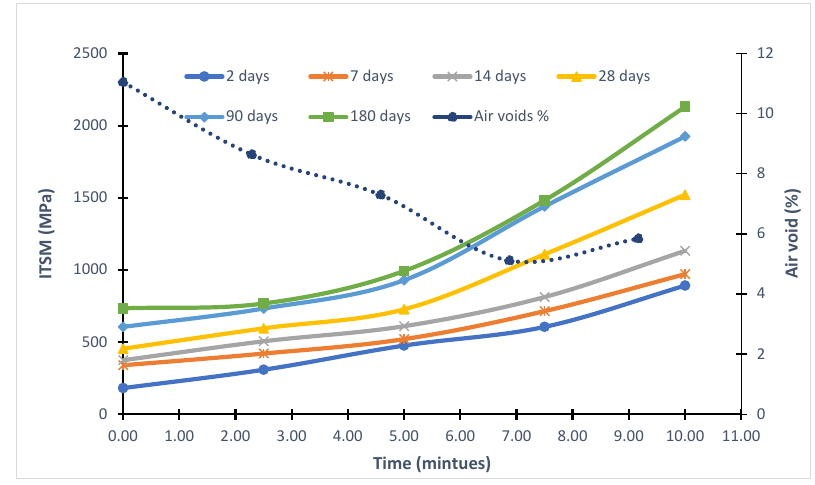
Figure 7. Impact of MW time on ITSM of traditional CBEM.